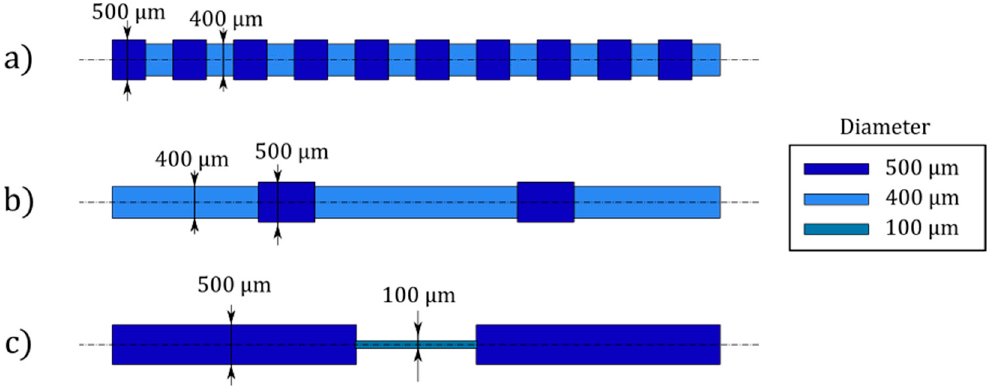
Figure 1. Inflatable cavity morphologies: ( a ) Saw , ( b ) Totem , ( c ) Halter . The cavities are axisymmetric, and the colour code corresponds to the local diameter of each segment. The segment lengths are reported in Table 1. Table 1. Inflatable cavities segments